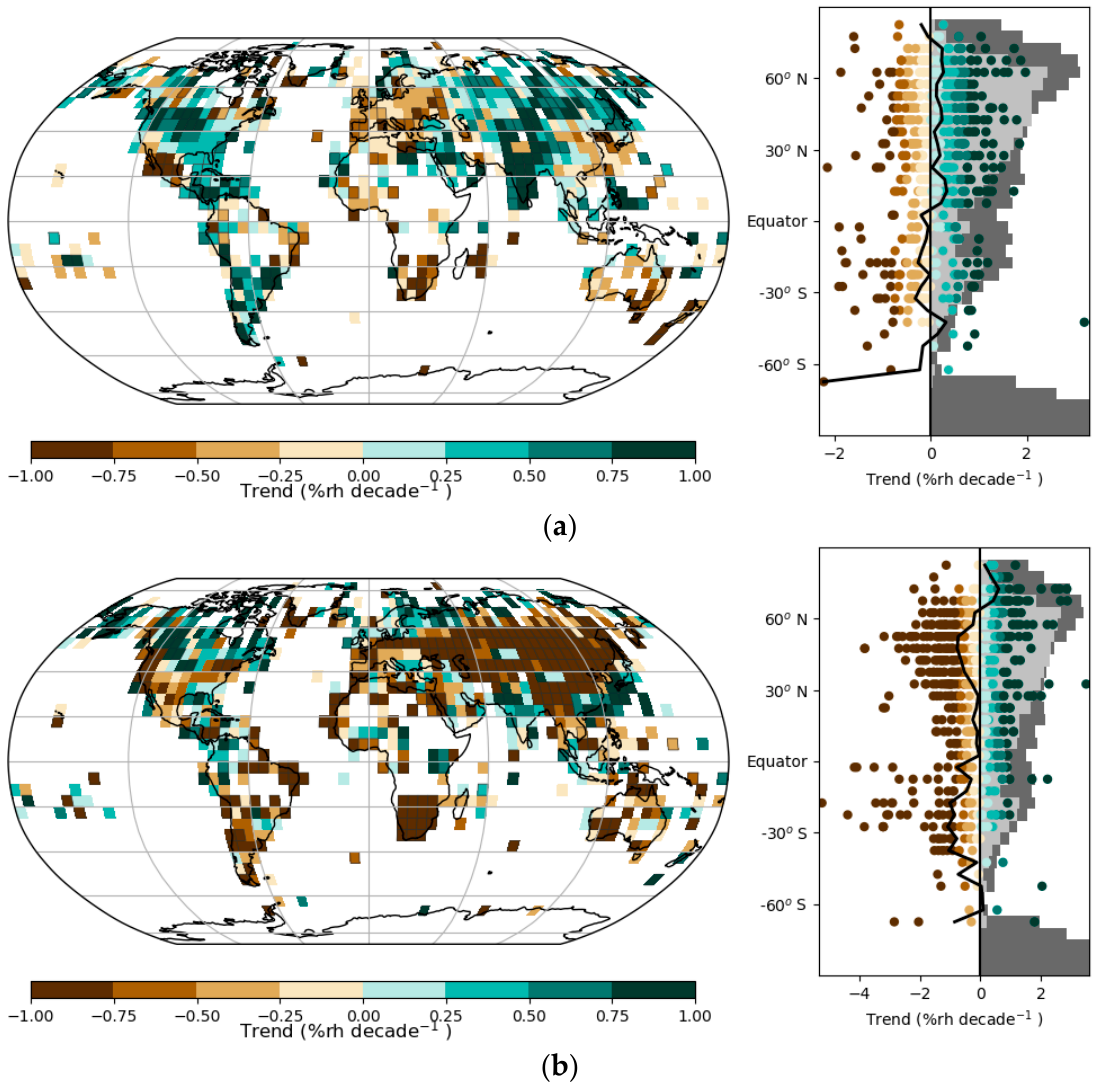
Figure 6. Trends for blended land and marine RH from the HadISDH dataset [26,28,30] showing trends ( a ) 1973–1999 and ( b ) 2000–2019 (center) on a 5° by 5° grid with latitudinal spread of results to the right, where light grey shows proportion coverage (source https://www.metof- fice.gov.uk/hadobs/hadisdh/trendmaterialBLEND.html, accessed 20 June 2020).